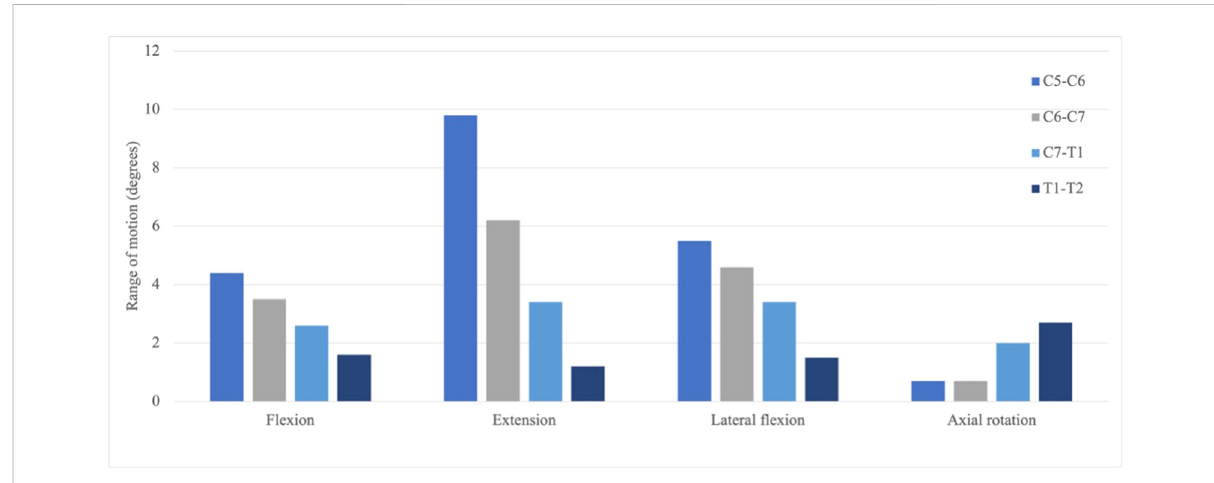
FIGURE 6 ROM of the intact joints under different loading